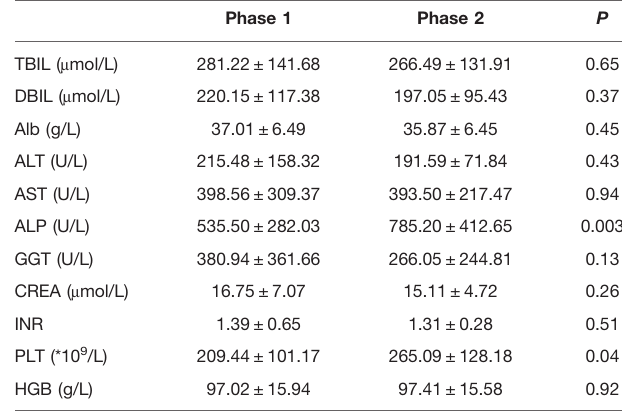
TABLE 3 | Patients ’ preoperative results according to phases of the learning